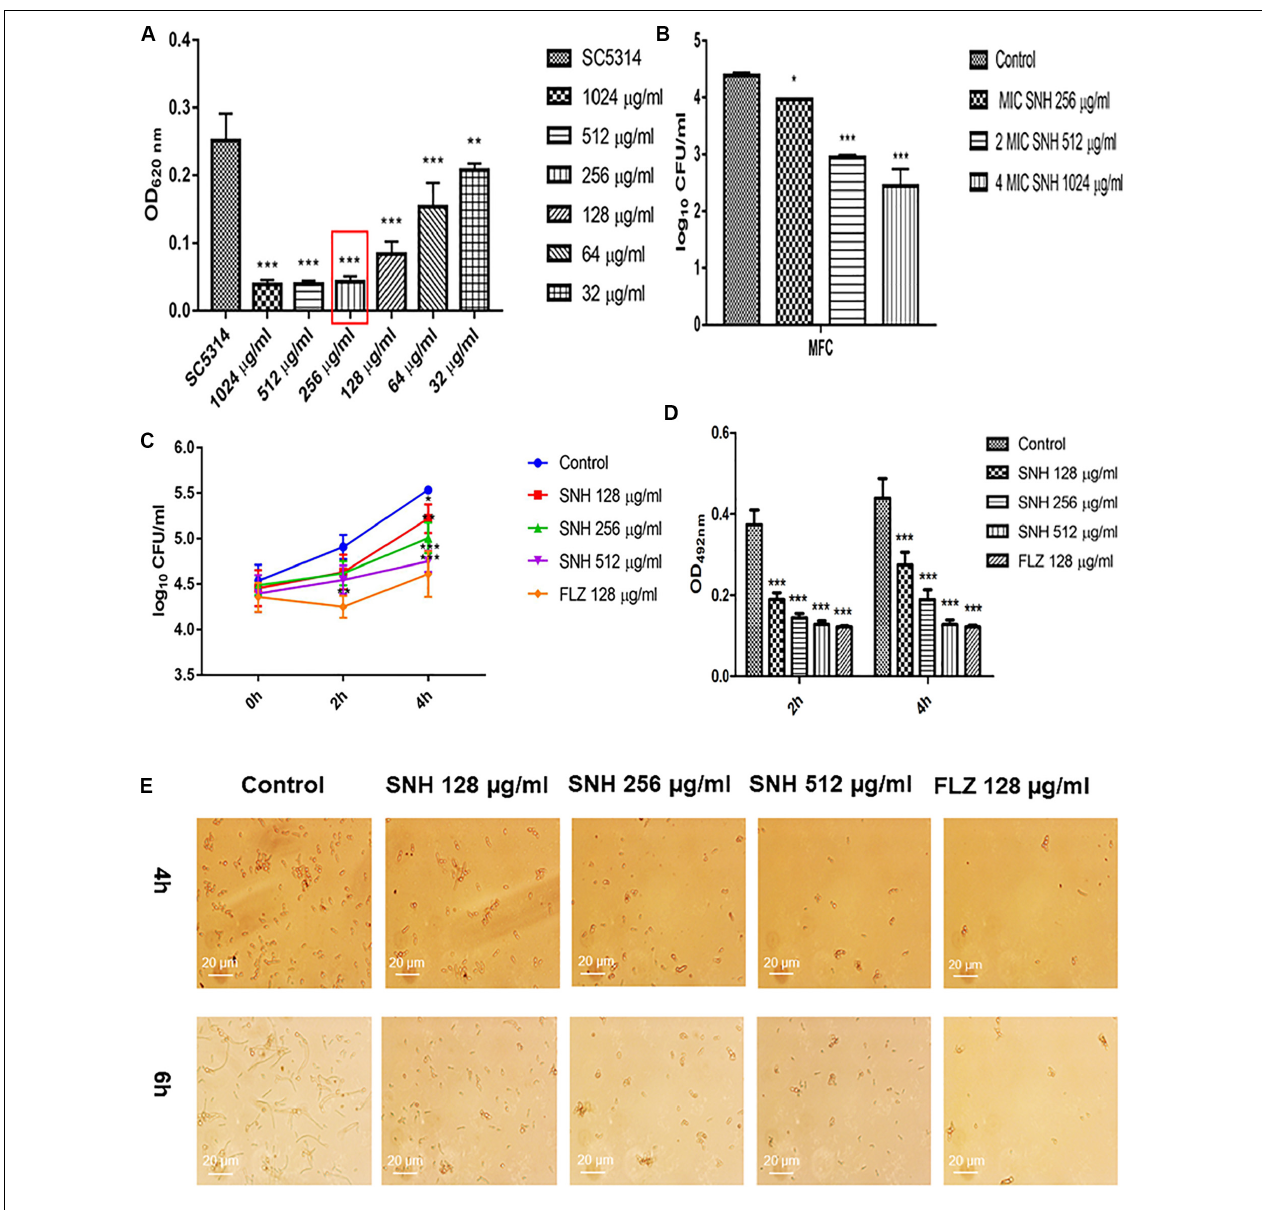
FIGURE 1 | (A) Determination of MIC 80 of SNH on C. albicans SC5314 by microdilution method. The drug-free strain-containing medium was set as the control. Data are shown as mean ± SD. *** p < 0.001 and ** p < 0.01, compared with the control. (B) Determination of MFC of SNH on C. albicans SC5314 by plate count. The drug-free strain-containing medium was set as the control. Data are shown as mean ± SD. *** p < 0.001 and * p < 0.05, compared with the control. (C) Effect of SNH on CFU of adhesive cells of C. albicans SC5314. The initial adhesive growth curve measurements were taken for the first 4h. The drug-free strain-containing medium was set as the control. Data are shown as mean ± SD. * p < 0.05, compared with the control. (D) Effect of SNH on adherence metabolic activity in C. albicans SC5314 by the XTT reduction assay. The drug-free strain-containing medium was set as the control. Data are shown as mean ± SD. *** p < 0.001, compared with the control. (E) Observation of morphological changes of C. albicans yeast (4 h) and hypha (6 h) by inverted microscope ( × 400). The initial inoculum was newly prepared at 2 × 10 6 CFU/mL. The drug-free strain-containing medium was set as the